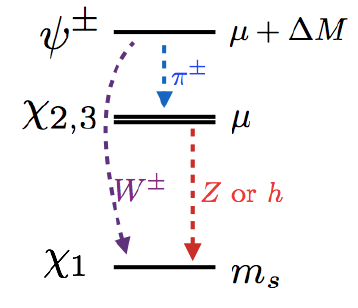
Figure 1 . Mass spectrum of the Singlet-Doublet model considered here and possible decay